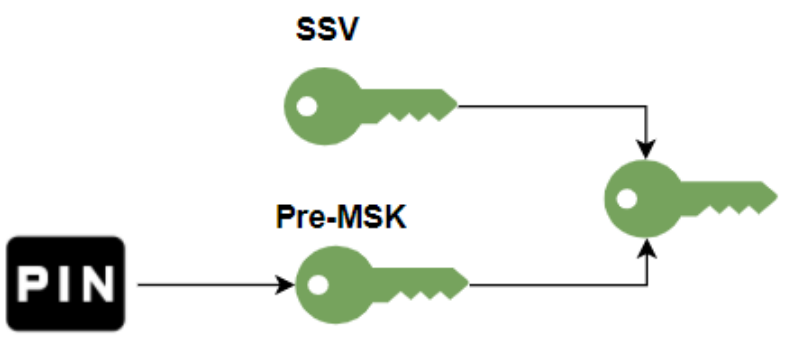
Figure 4. Patient PIN